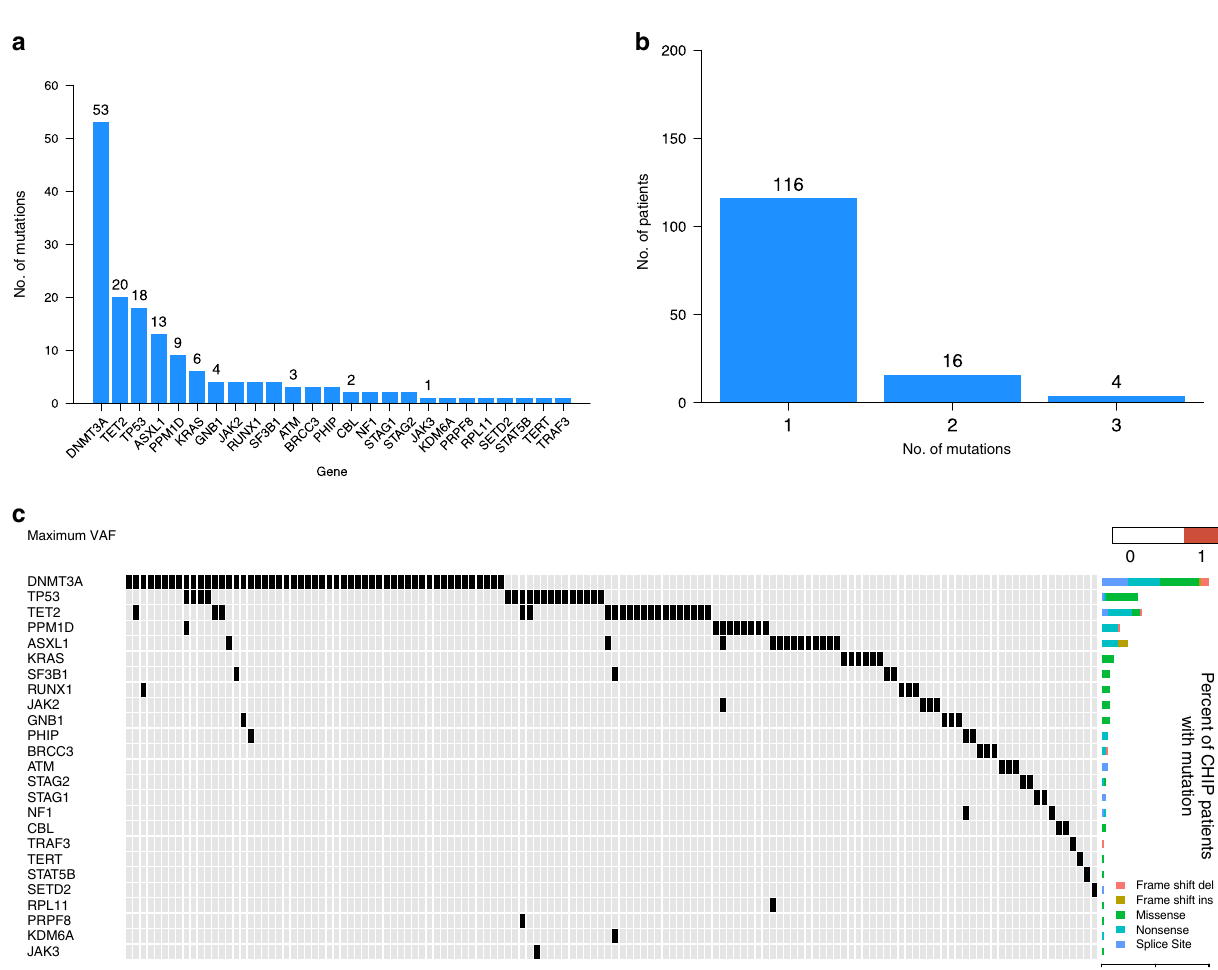
Fig. 1 Mutational spectrum of CHIP in hematopoietic cells of multiple myeloma patients at the time of autologous stem cell transplant. a The total number of patients harboring one or more mutations in each gene. b Number of patients harboring mutations in 1, 2, and 3 different genes. c Comutation plot showing mutations present in all 136 patients: each column represents a single patient. The top row denotes the maximum VAF in each patient, with darker shades of red indicating higher VAF. The VAF cutoff used to call mutations was 0.01. The bar graph on the right designates the percentage of the different mutation subtypes for each gene out of all detected CHIP